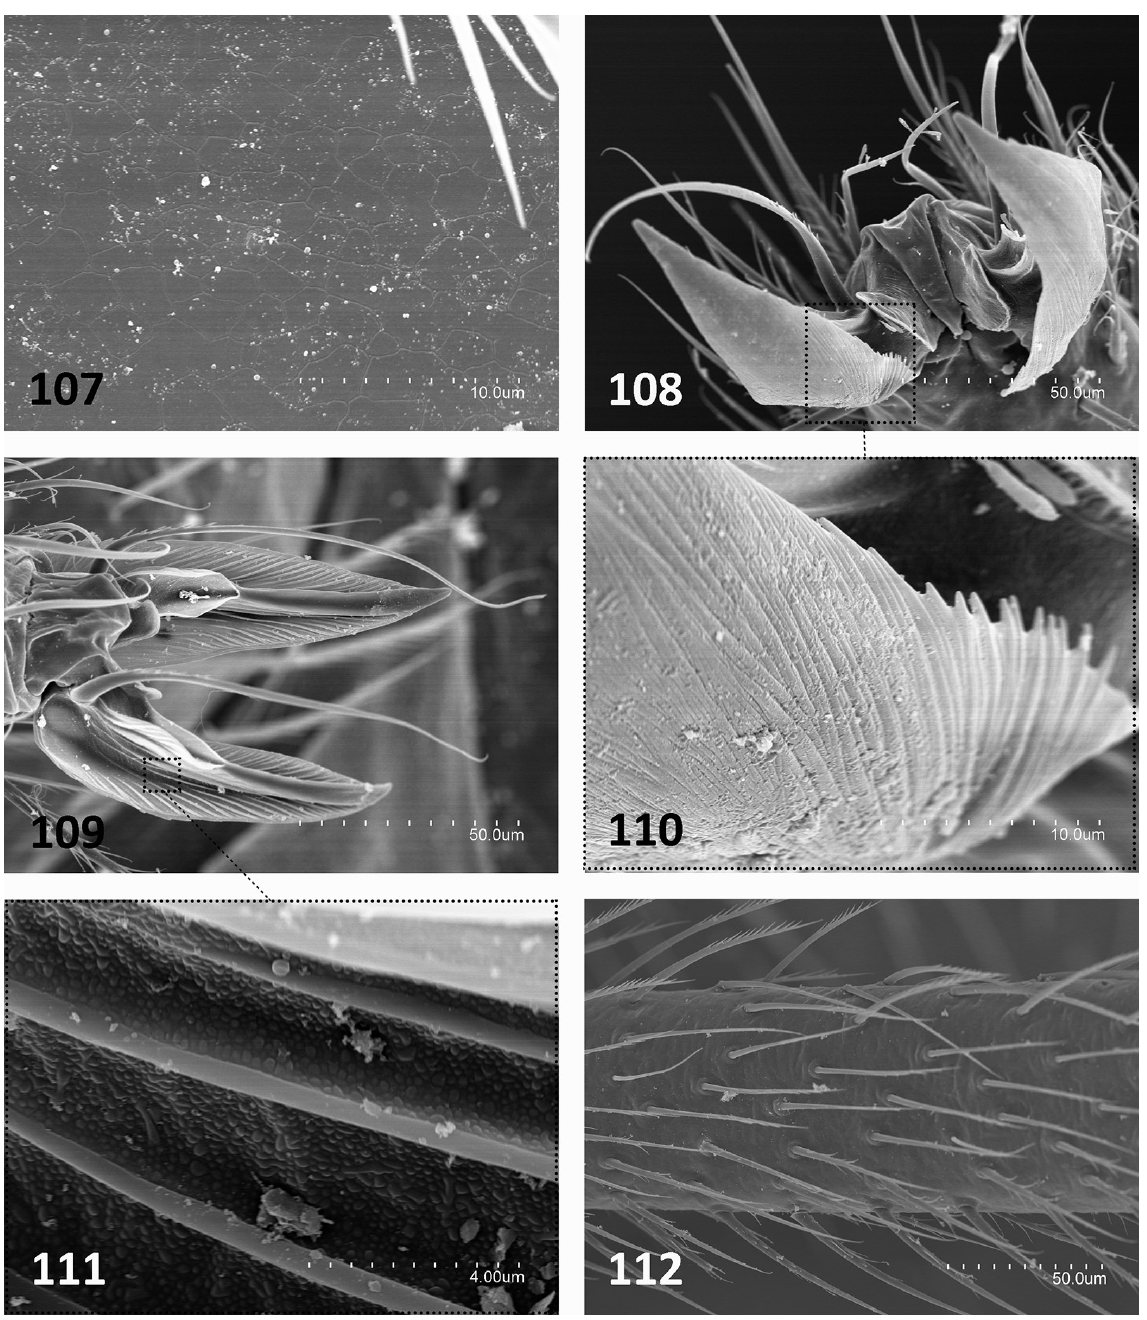
Figs 107–112. Plusiocampa ( Plusiocampa ) lagari Sendra & Condé, 1987, from Chorros Cave, Riopar, Albacete, Spain (Coll. AS). 107 . Surface of metanotum, detail. 108 . Pretarsus, frontal-dorsal view. 109 . Pretarsus, ventral view. 110 . Lateral crest of posterior claw, detail. 111 . Lateral crest, ventral view, detail. 112 . Portion of medial